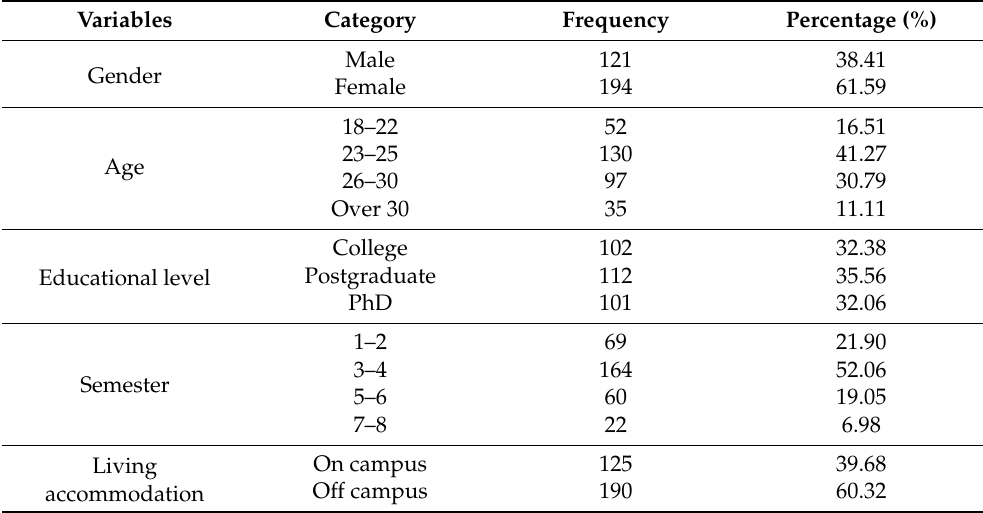
Table 2. Descriptive statistics for the respondents ( n =